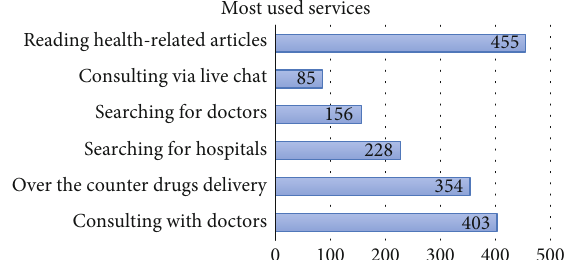
Figure 3: Services used by respondents. Note: Each respondent can select more than one service.